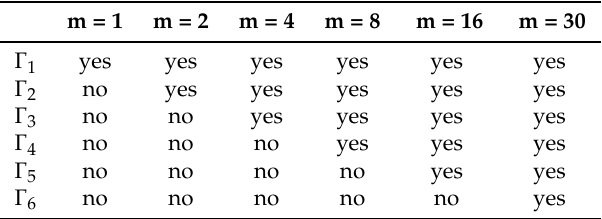
Table 4. Schedulability of the Task